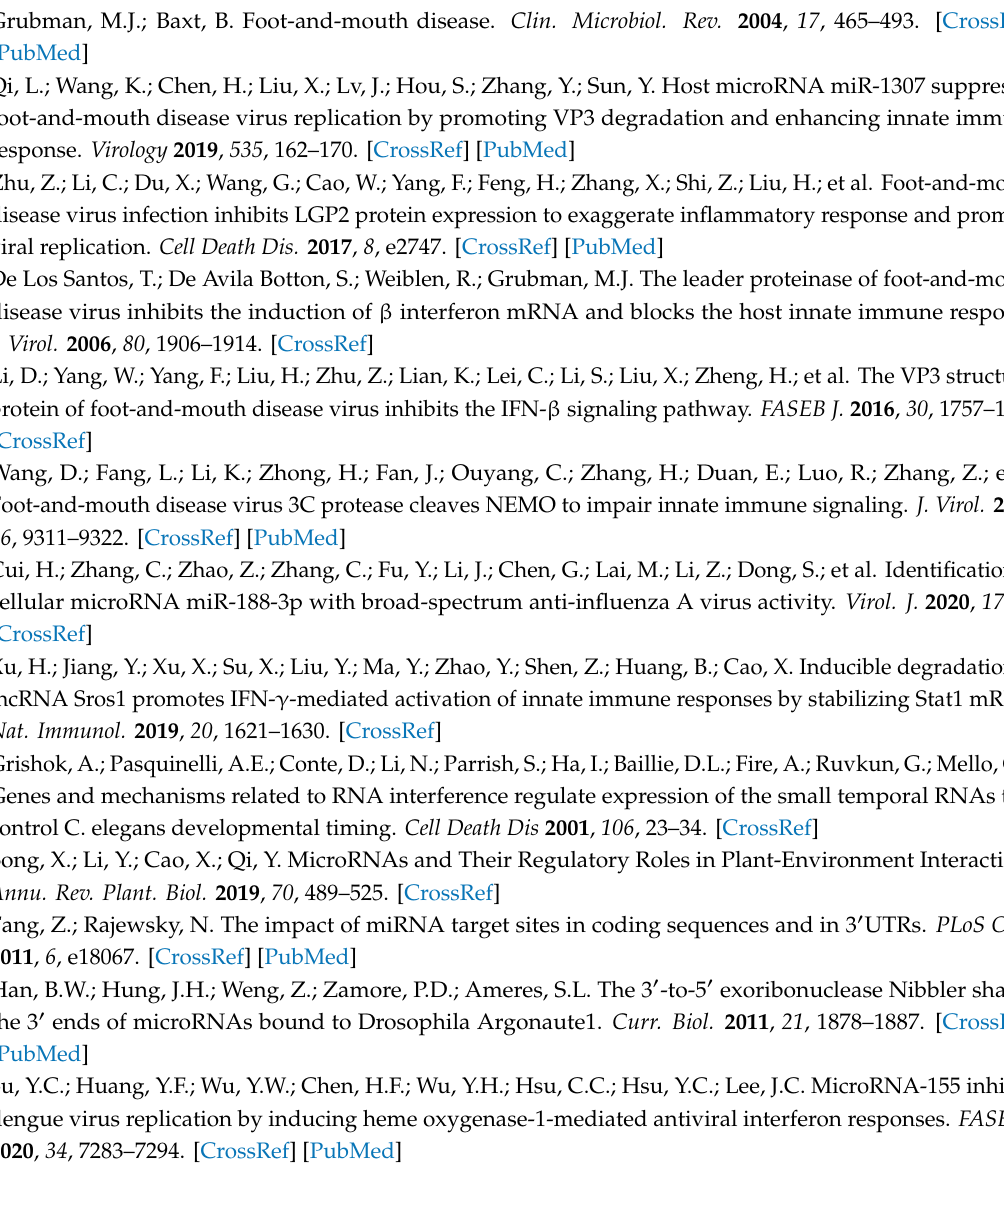
Figure S1: Bioinformatics analysis demonstrated miR-4334-5p participated in interferon